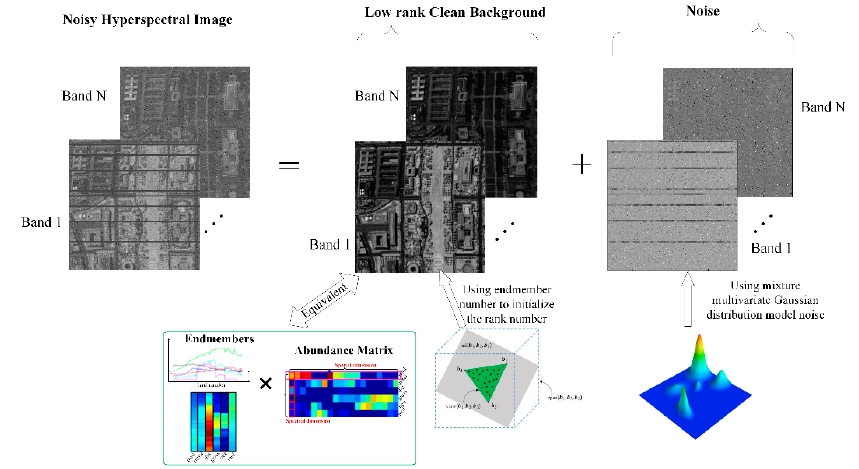
Figure 2. Framework of the proposed method.